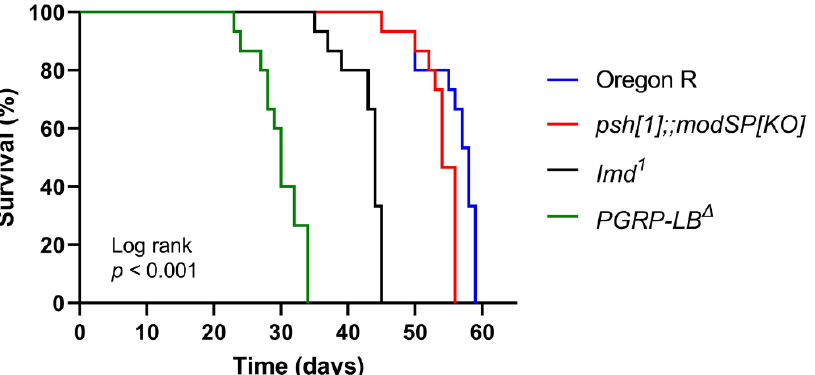
Figure 1. The lifespan of several lines of Drosophila melanogaster . Male flies of different lines were maintained at 25 ◦ C in normal fly food. The numbers of surviving and dead flies were recorded daily, and fly survivorship was analyzed using a Kaplan–Meier Log Rank approach.